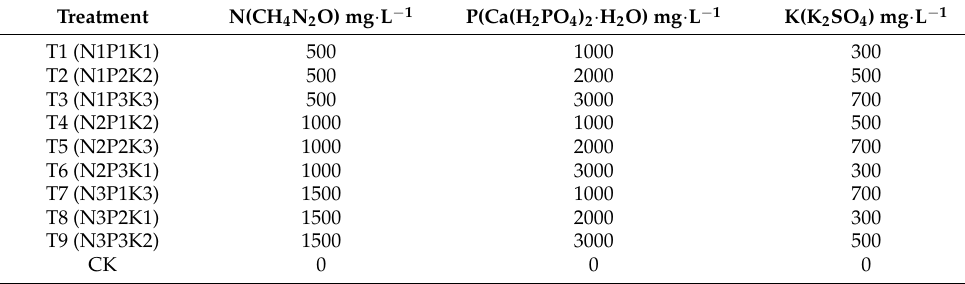
Table 4. Concentrations of nitrogen, phosphorus, and potassium in each